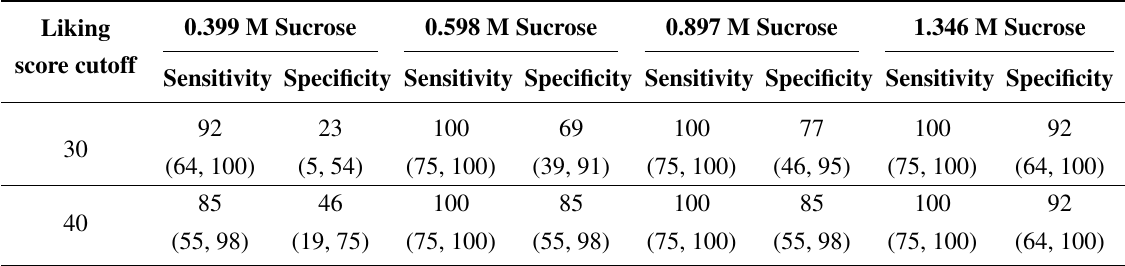
Figure 2. Response curves for liking scores against sucrose concentrations by cluster. The left panel displays the standardized scores of “low concentration likers” (cluster 1), n = 13; the right panel displays the standardized scores of “high concentration likers” (cluster 2), n = 13. Table 2. Sensitivity and specificity in percentage (95% confidence interval) to identify “high concentration likers” (cluster 2) based on the liking score for one sucrose concentration.